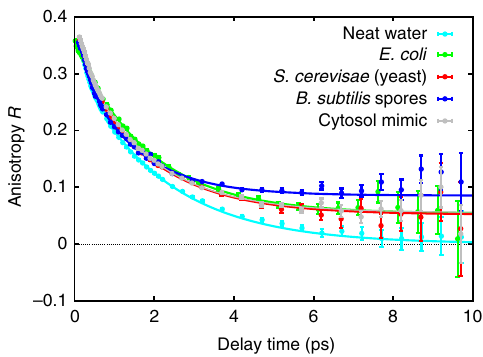
Fig. 2 Time-resolved infrared spectroscopy measurements of water dynamics. Transient anisotropy of the OD-stretch mode (2508 cm − 1 ) of HDO water in different organisms and in a cytosol-mimic solution (pH 7, with protein). The error bars represent 1 σ . The curves are least-squares fi ts to exponential decays with a residual offset (see Supplementary Table 2 for the fi